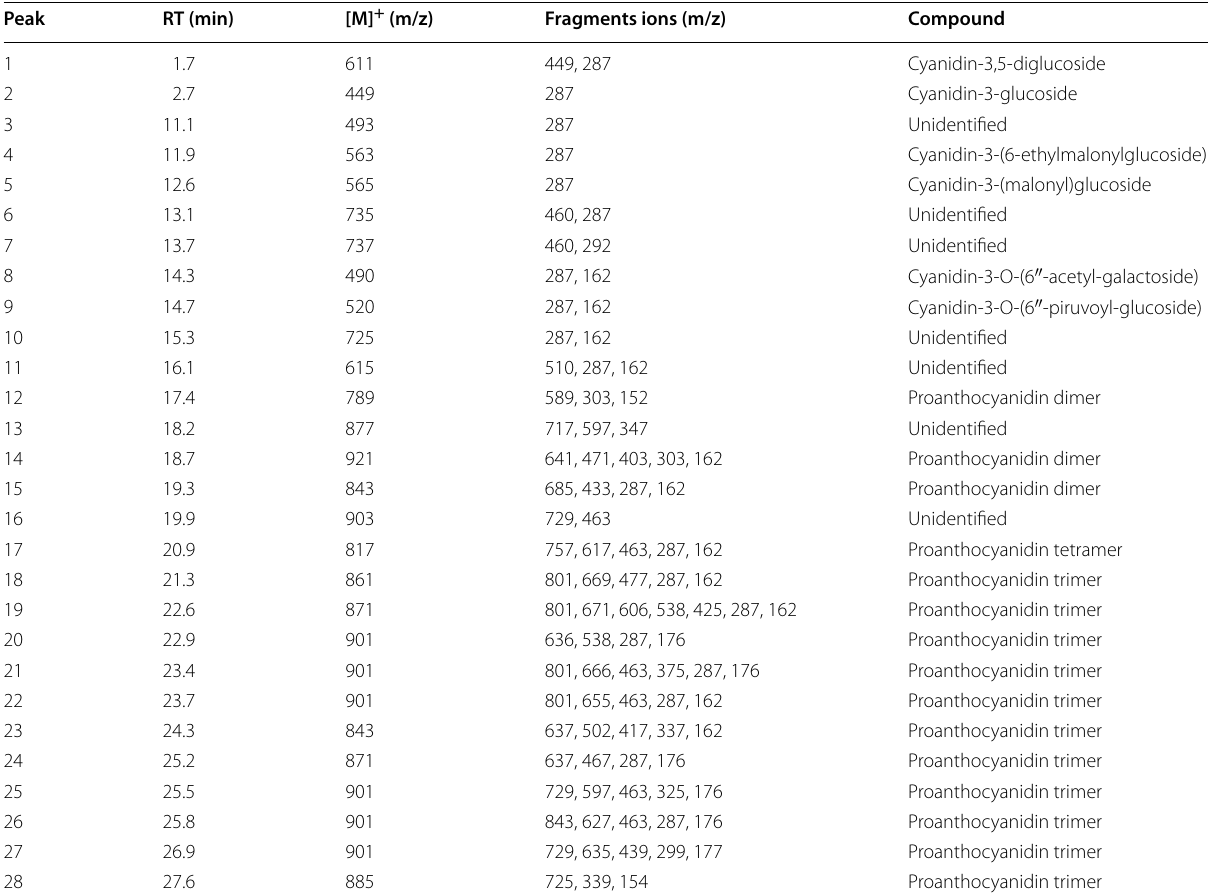
Table 2 Identification of anthocyanins in tortilla extract from blue Mixteco maize